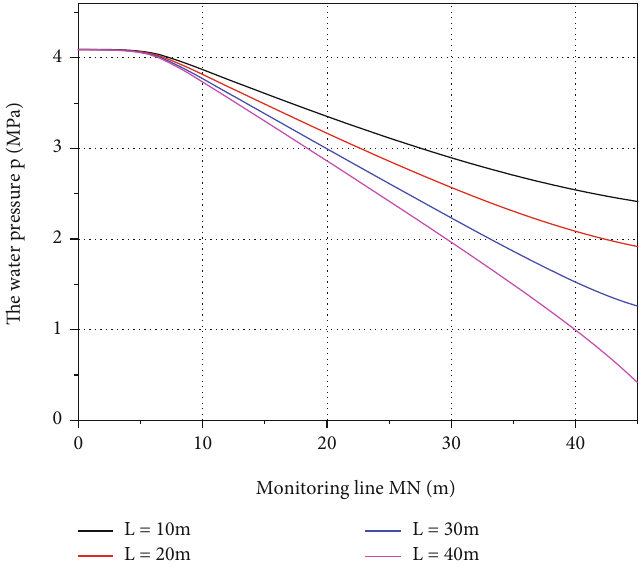
Figure 6: Variation of water pressure in monitoring line M-N under four working